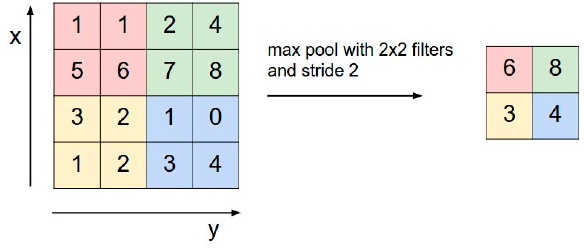
Figure 5. Max pooling over a 2 × 2 region with stride of 2.